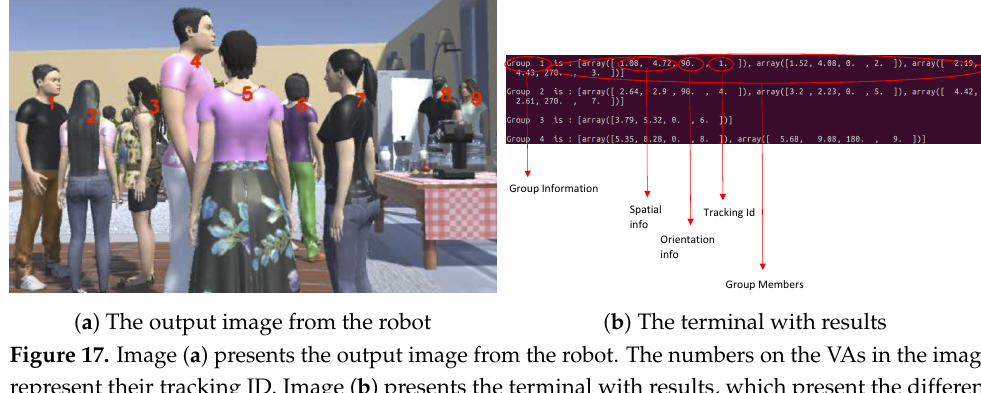
Figure 17. Image ( a ) presents the output image from the robot. The numbers on the VAs in the image represent their tracking ID. Image ( b ) presents the terminal with results, which present the different groups’ information, i.e., the number of groups, the VAs in the group, their spatial and orientational information, and their tracking